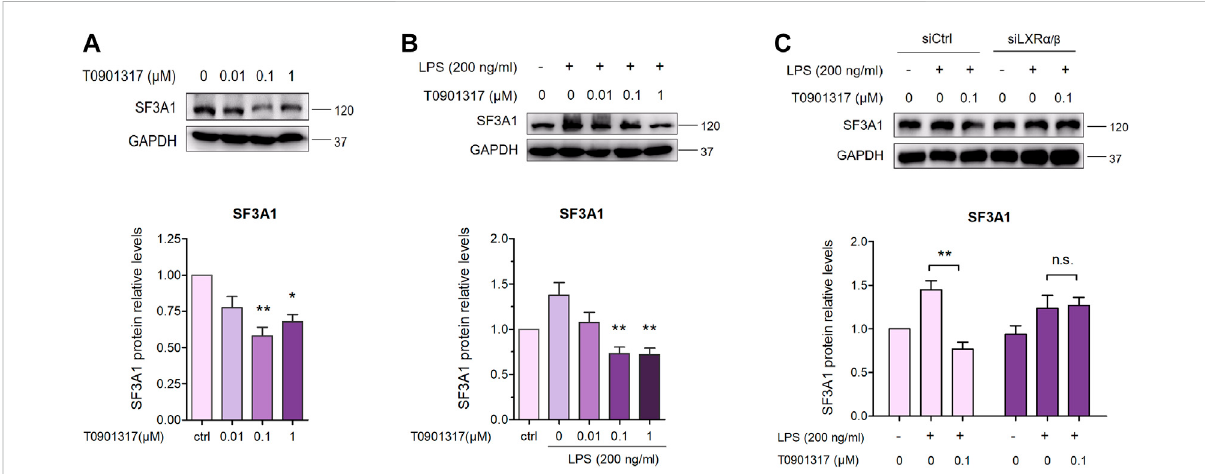
FIGURE 9 T0901317 decreases SF3A1 protein expression in RAW264.7 macrophages. (A) RAW264.7 macrophages were treated with T0901317 (0, 0.01, 0.1, or 1 μ M) for 18 h (B) RAW264.7 macrophages were exposed to LPS (200 ng/mL) and T0901317 (0, 0.01, 0.1, or 1 μ M) for 18 h (C) RAW264.7 macrophages were transfected with negative control siRNA or LXR α / β siRNA for 24 h, then exposed to LPS (200 ng/mL) and T0901317 (0 or 0.1 μ M) for 18 h SF3A1 protein levels were measured by western blot, normalized to GAPDH expression. Similar results were obtained in three independent experiments. Values are expressed as means ± SEM and were analyzed by one-way ANOVA. * p < 0.05, ** p < 0.01.